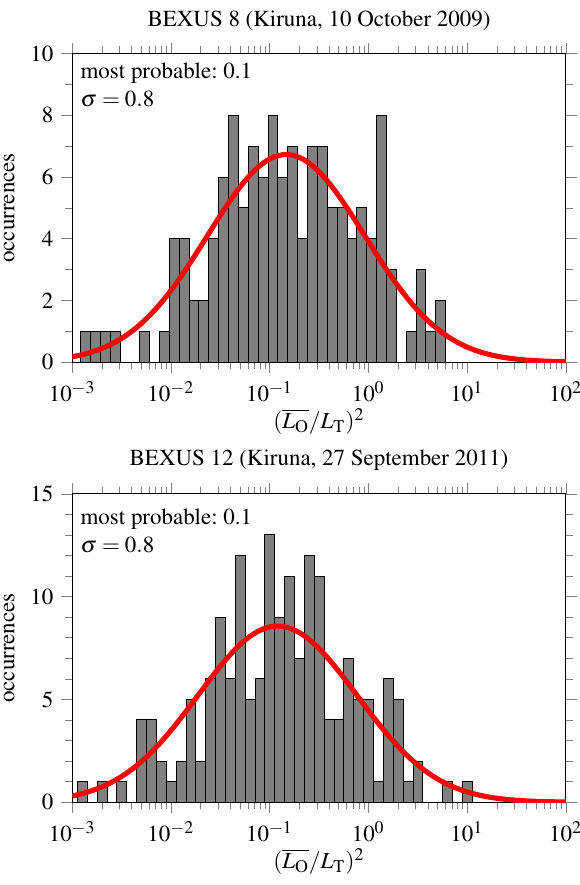
Figure 6. Statistics for the ratio (L O /L T ) 2 for the BEXUS 8 (top) and BEXUS 12 (bottom) flights. The red curves show the most likely normal distributions for the logarithmic